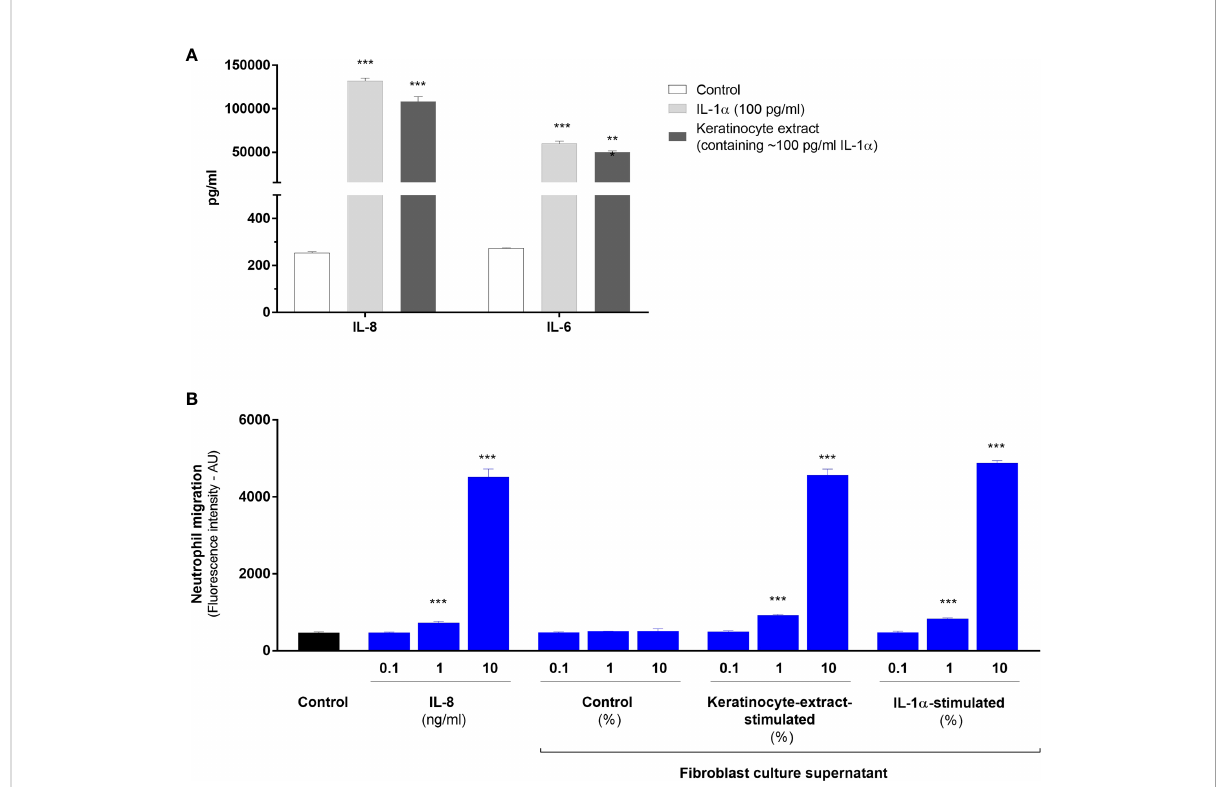
FIGURE 6 IL-1-activated fi broblasts have the capacity to attract neutrophils in vitro . Concentrations of IL-8 and IL-6 were determined by ELISA in culture supernatants from dermal fi broblasts stimulated with IL-1 a at a concentration of 100 pg/ml or a half-diluted keratinocyte extract containing IL- 1 a at a similar concentration of 100 pg/ml (A) . Analysis of cell migration determined by Boyden chamber assays (B) . Polymorphonuclear cells were seeded in the upper compartment for migration and the lower compartment contained either culture medium (control), or different concentrations of IL-8, control supernatant of unstimulated fi broblasts or supernatants from fi broblasts stimulated either with IL-1 a (100 pg/ml) or a half-diluted keratinocyte extract. Data were obtained from 2 independent experiments done in triplicate and presented as mean fl uorescence intensity ± SEM. *** P < 0.001 using the Mann & Whitney ’ s